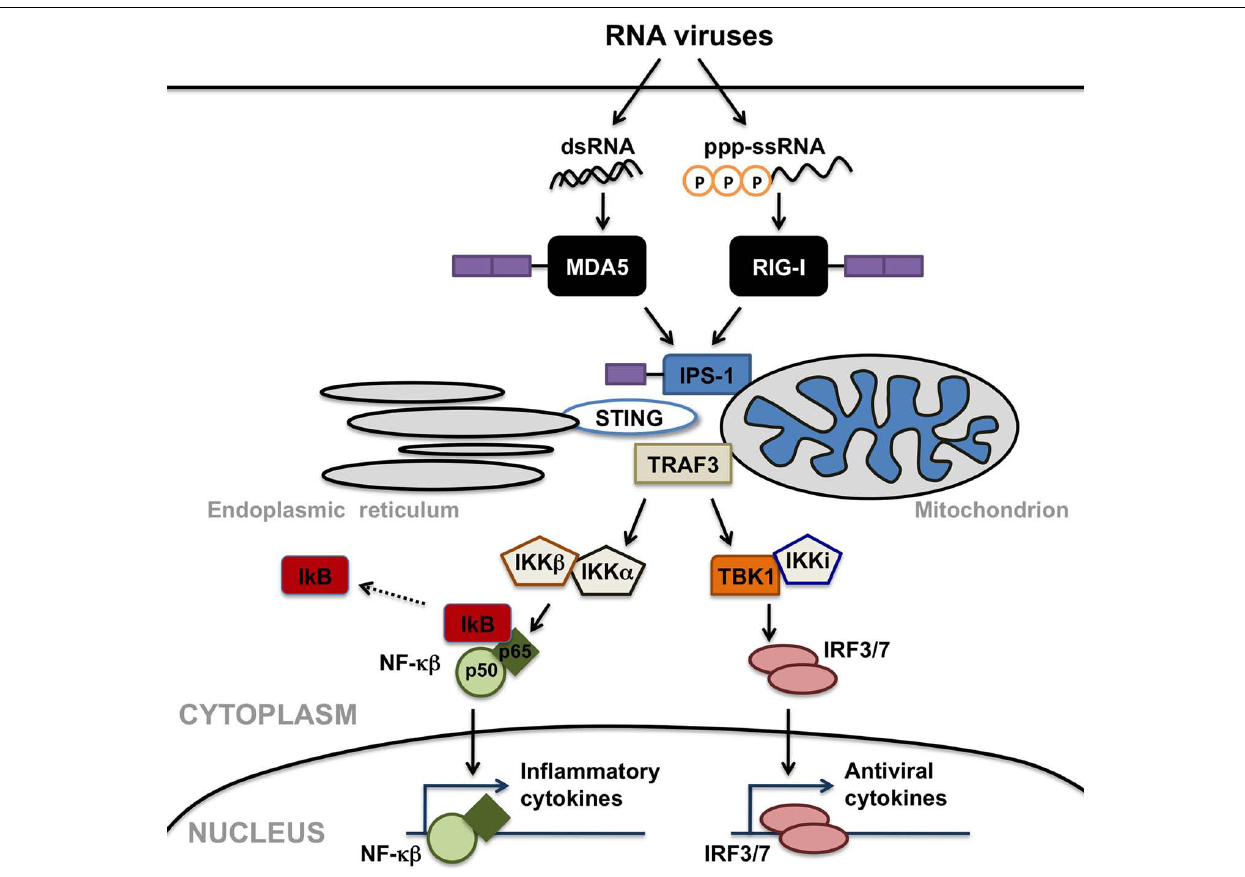
peroxisomal-associated interferon promoter stimulator (IPS)-1,TNF receptor associated factor (TRAF) 3, and/or stimulator of interferon genes (STING), leading to the activation of I κ B kinase (IKK)-related kinases,TRAF family member-associated NF- κ B activator binding kinase 1 (TBK1), and IKK-I.These kinases activate the transcription factors NF- κ B and interferon-regulatory factors (IRF) 3, which translocate into the nucleus and activate transcription of anti-viral and inflammatory